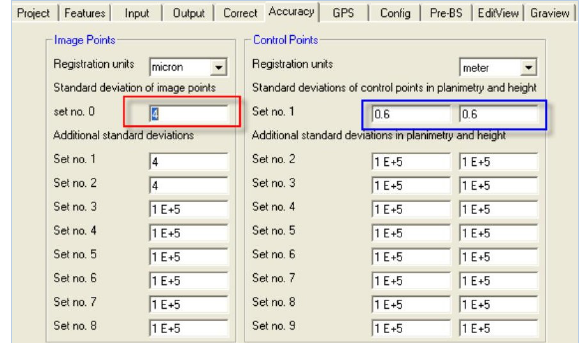
Figure 9. PATB adjustment parameter settings